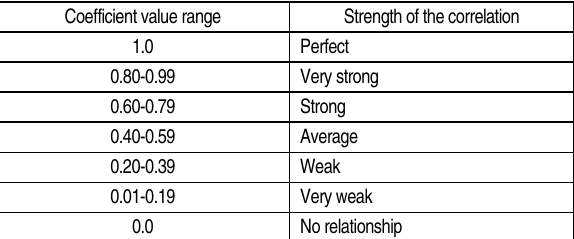
Table 3. Interpretation of the correlation coefficient